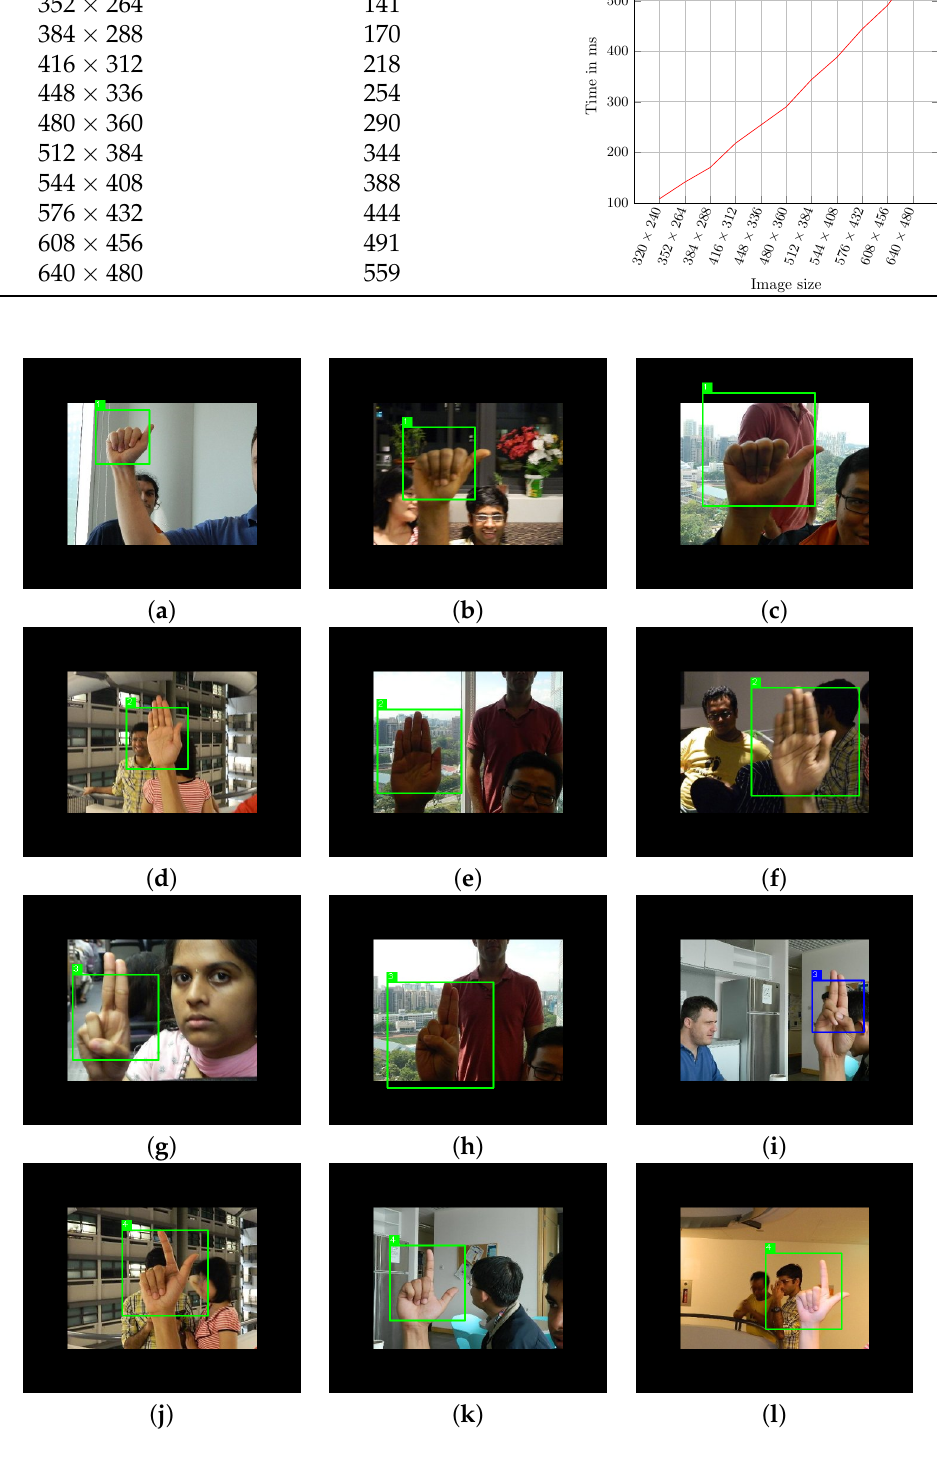
Figure 9. Results obtained from the multi-posture detector in the NUS-II-B. We select images with different lighting conditions, different backgrounds and different users. In ( i ), the detection